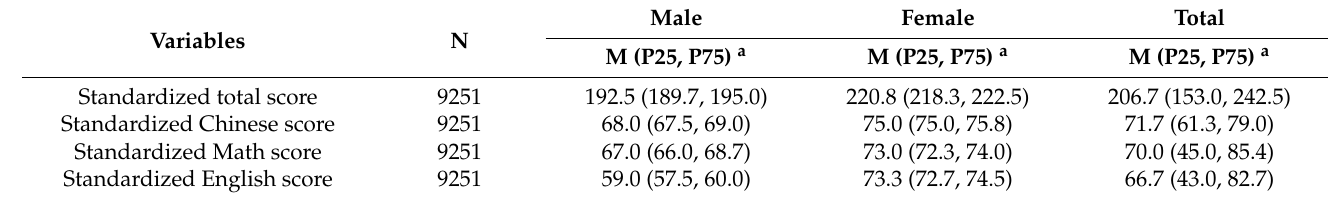
Table 2. Description of the academic performance of these junior school students.